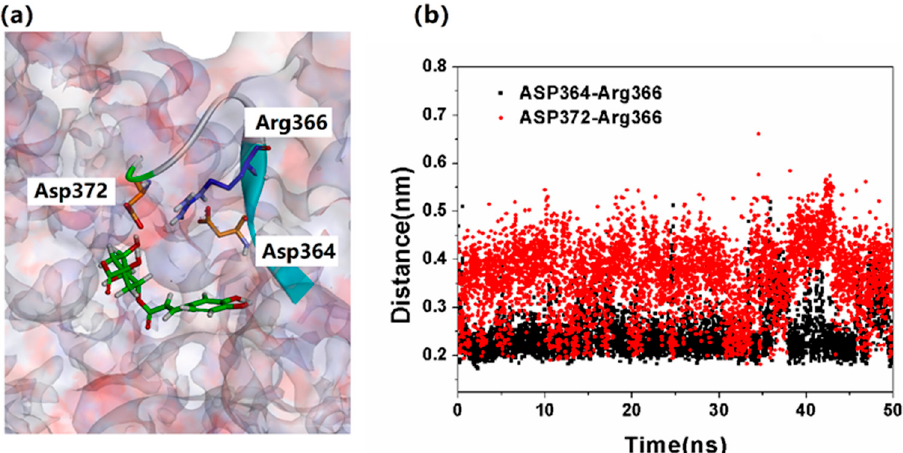
Figure 9. ( a ) The salt bridge between Arg366 and Asp372/Asp364. ( b ) The monitored distance between Arg366 and Asp372/Asp364.